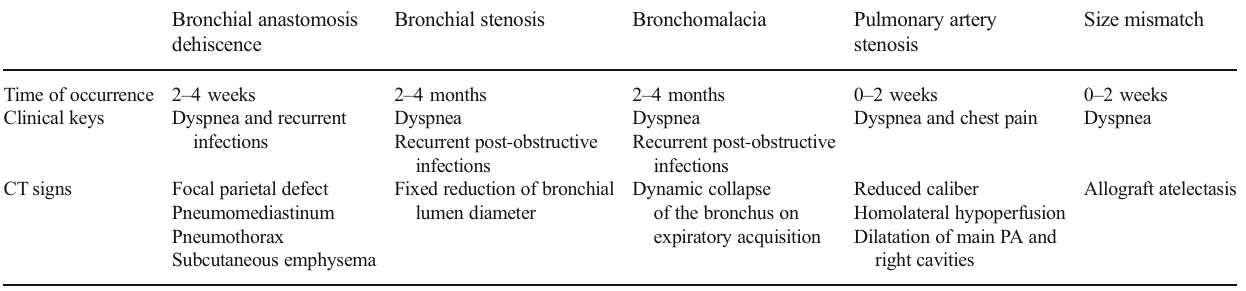
Fig. 3 Bronchial anastomosis dehiscence. Air collection anterior to the right bronchial suture ( arrow ) ( a ). Indirect signs include persistent pneumothorax ( arrow ) and new subcutaneous emphysema ( arrowheads ) ( b )